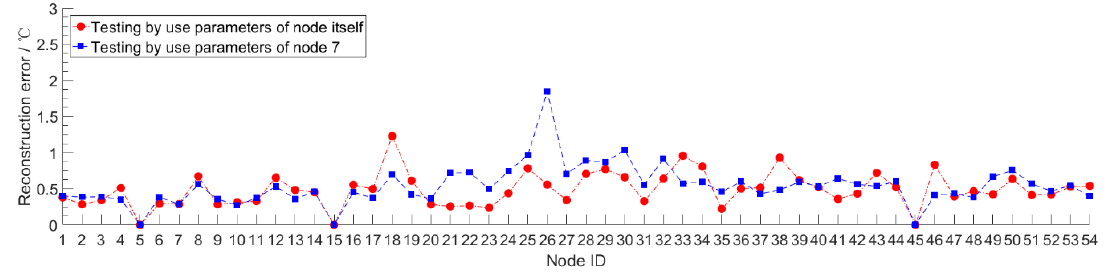
Figure 11. The reconstruction error of each node on testing with different model parameters.